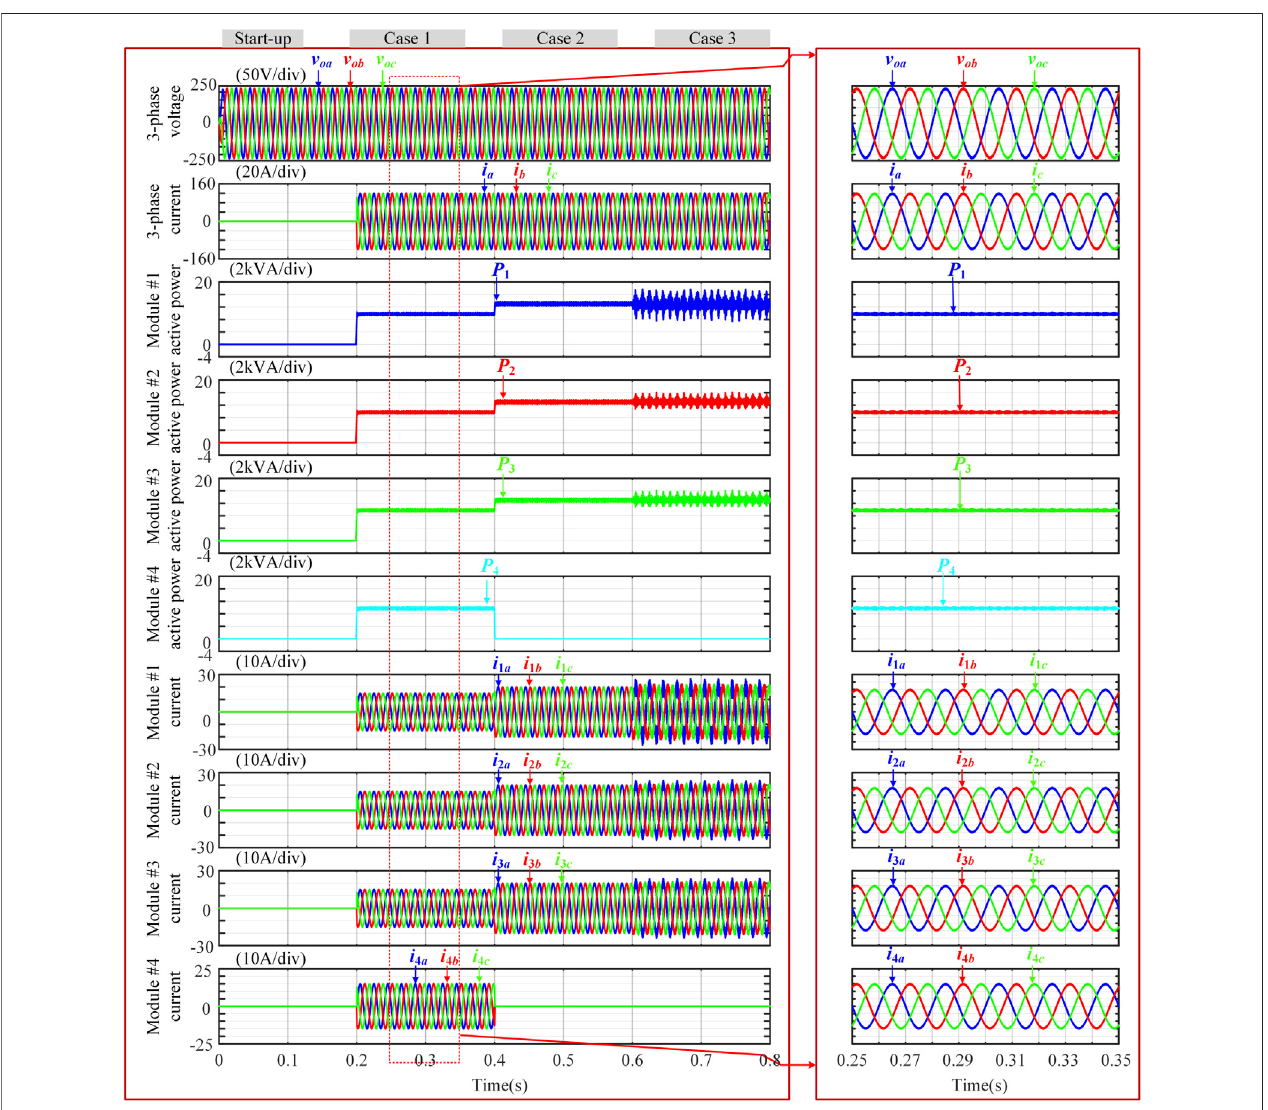
FIGURE7| Three-phasesimulationresultsbyusingPI-basedcontrolincludingscenariosof1)startup(from0to0.5 s),2)modulewithoutmismatch#1case(from 0.2 to 0.4 s), 3) module failure #2 case (from 0.4 to 0.6 s) and 4) module-mismatch #3 case (from 0.6 to 0.8 s).